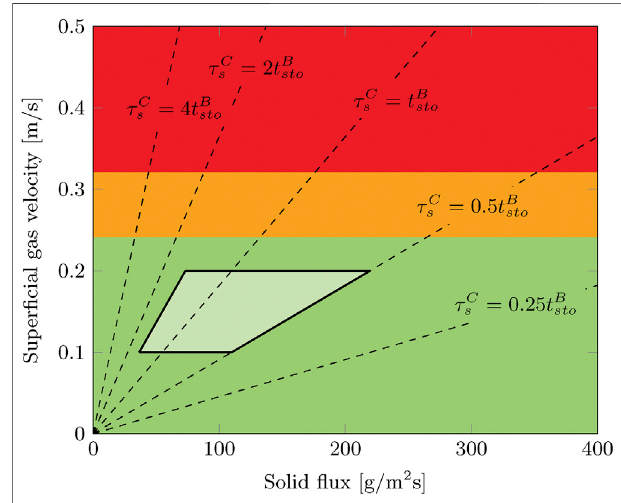
FIGURE 5 | Operation window for moving bed operation in the radial fl ow contactor. The solid fl ow is either good (green, u (orange, 0 . 24 < u g < 0 . 32 m / s) or blocked (red, u g > 0 . 32m /